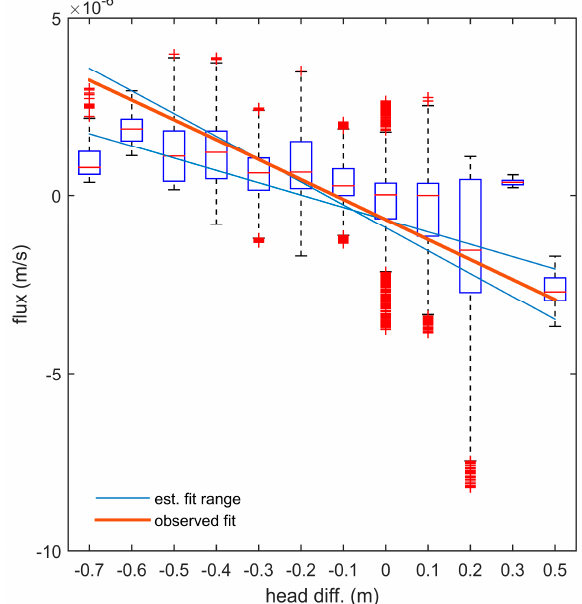
Figure 7 . Relationship between model-estimated vertical flux rates and the head gradients between the river stage and inland water level based on 100 realizations of randomly selected combinations of sediment properties at Spring 9.